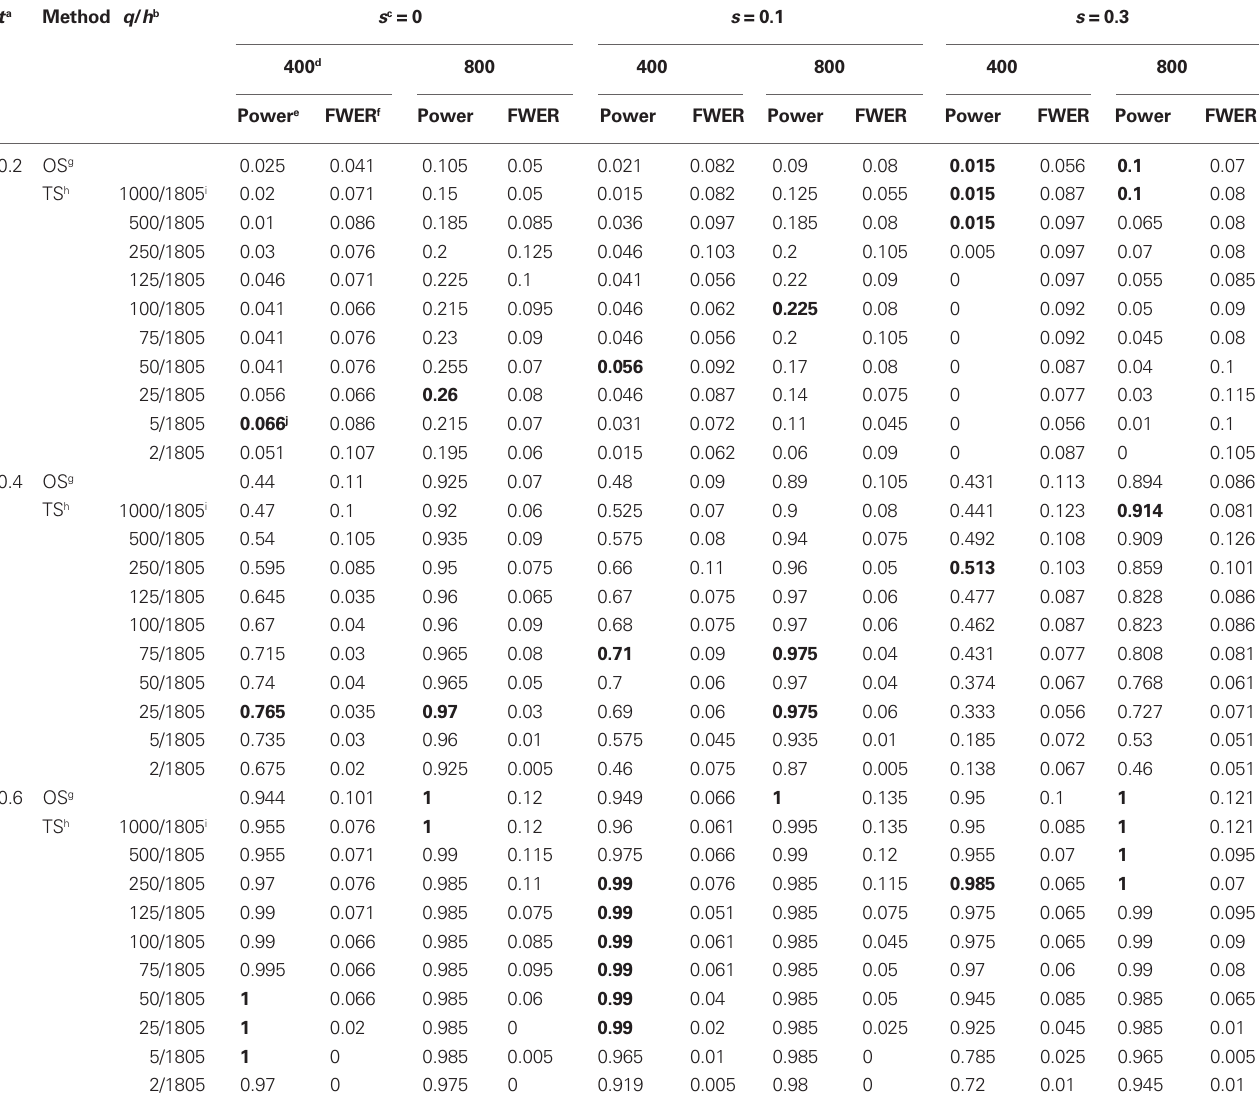
Table A5 | empirical power and FWer of the two-stage procedure at a significance level of 0.1 (200 replicates). t